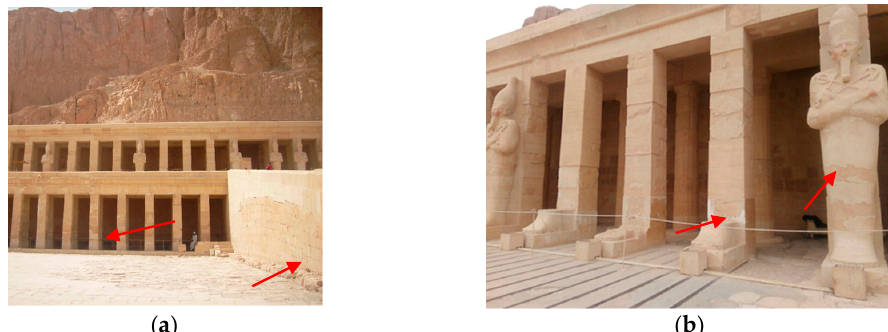
Figure 10. Deterioration in the inscriptions and writings in the walls of Hatshepsut temple ( a , b ).